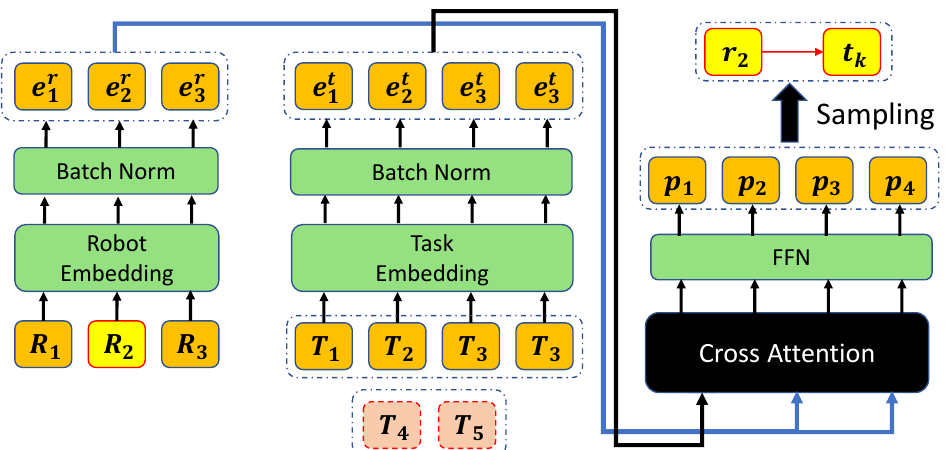
Figure 3. The neural network architecture for the MRTA. The robot to be allocated is r 2 and the remaining tasks are ( t 1 , t 2 , t 3 , t 4 ) . Tasks t 4 , t 5 are finished tasks and they are not used in the model. After normalizing the logits, we sample action from the probability. Here the robot r 2 is allocated to t k where t k ∈ { t 1 , t 2 , t 3 , t 4 } . Best viewed in color.